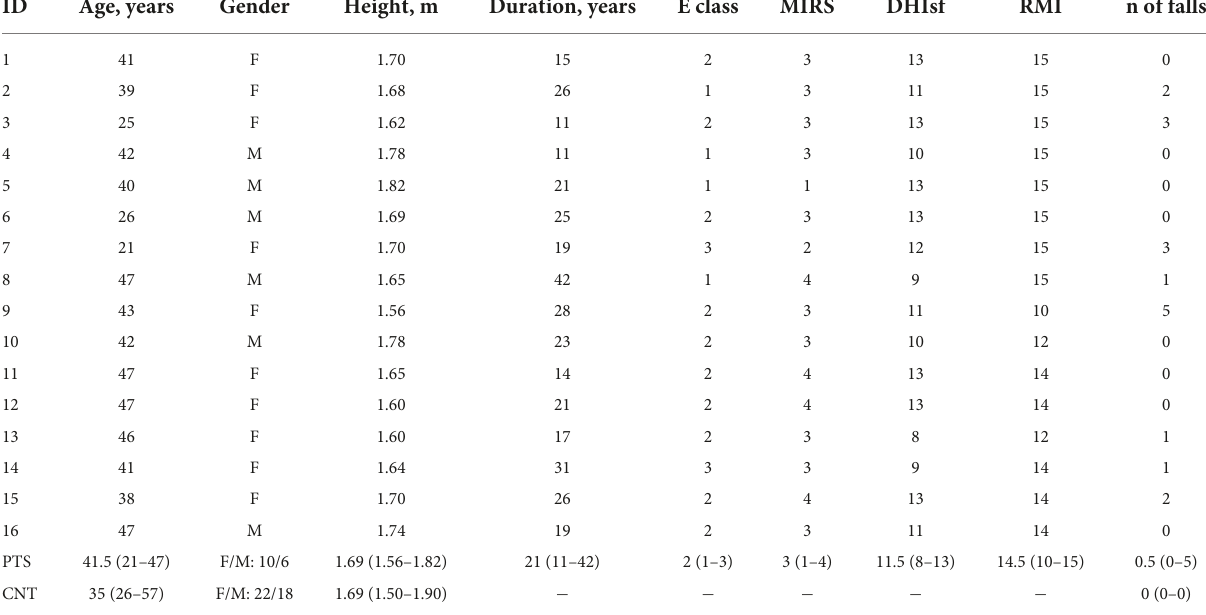
TABLE 1 Patients’